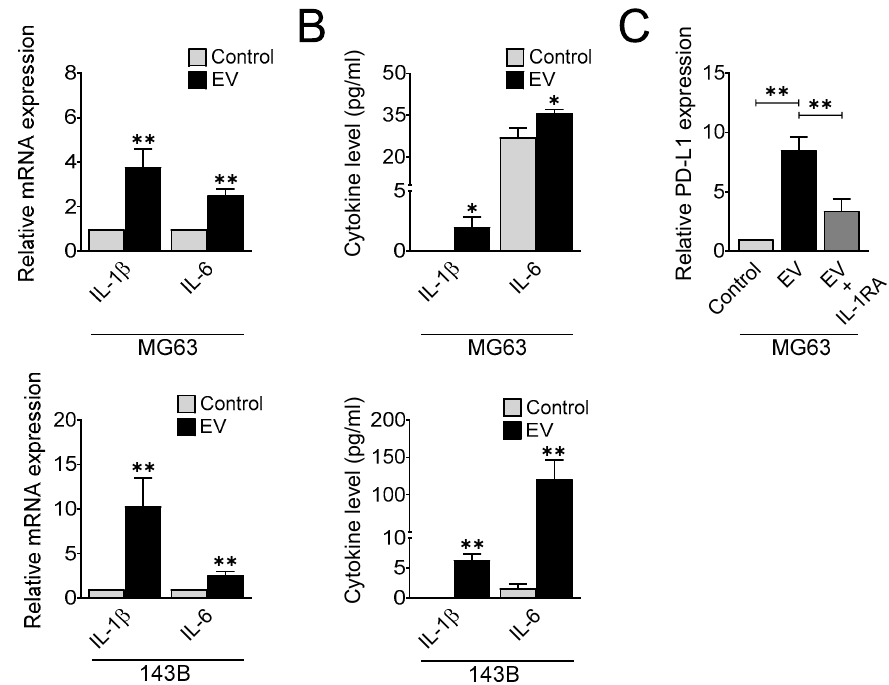
Figure 6. Doxorubicin-derived extracellular vesicles regulate IL-1 β and IL-6 expression. IL-1 β and IL-6 gene ( A ) and protein ( B ) expression after EV treatment. Human osteosarcoma cells were treated with 50 µg/mL of EVs and analyzed for IL-1 β and IL-6 gene and protein expression by qRT-PCR and ELISA, respectively. The data represent the means ± SD. *, p < 0.05 and **, p < 0.01 vs. control. ( C ) PD-L1 gene expression after EV treatment. Osteosarcoma cells were treated with 100 µg/mL of EV in the presence or absence of IL-1RA (100 ng/mL) for 24 h, and qRT-PCR was performed to determine PD-L1 gene expression. The data represent the means ± SD. **, p < 0.01 vs. control.